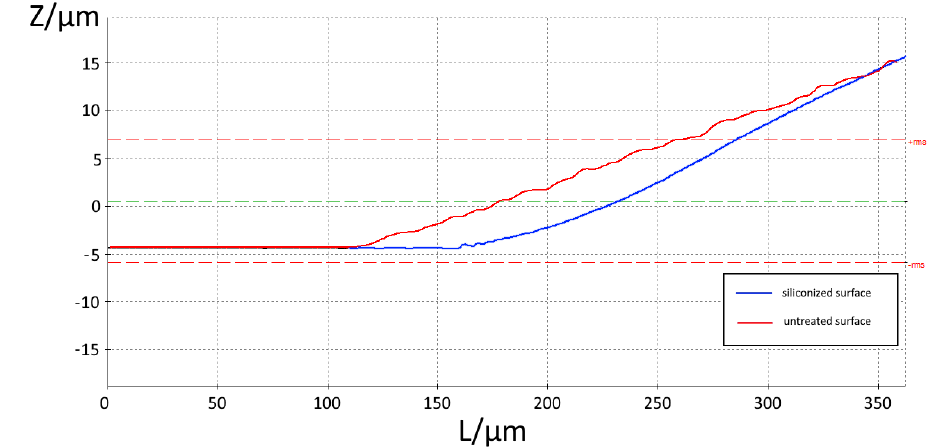
Figure 4. The profile of the droplet edge (L: length; Z: height of the droplet) shows a correlation between the surface composition and the profile of the droplet in the edge region. Due to the better wettability of a siliconized copper surface, the contact angle converges at the outer edge and forms a thin film already visible in the microscopic image (cf. Figure 5).